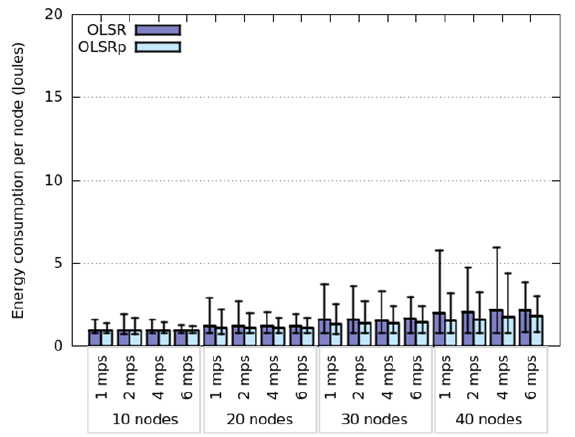
Figure 12. Energy consumption when nodes follow a Random Walk model.